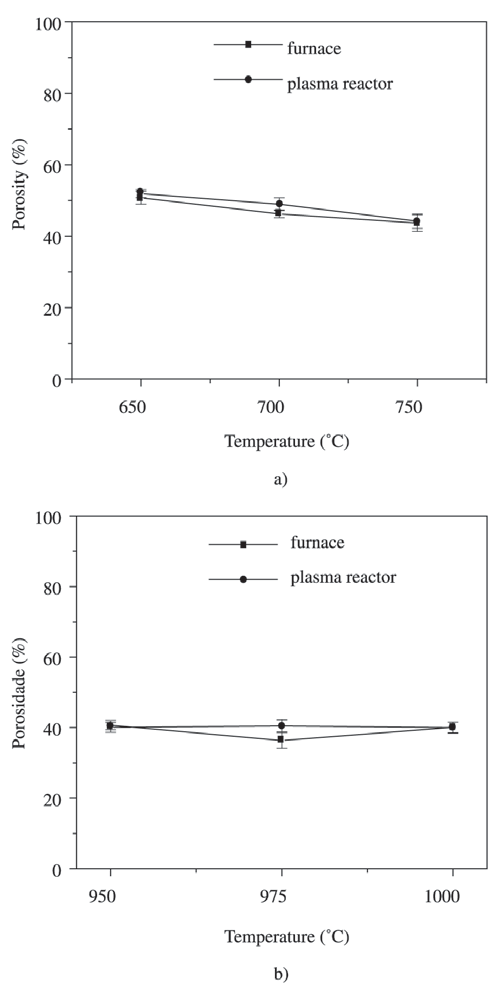
Figure 3. Porosity by Arquimedes method: a) nickel samples; b) stainless steel